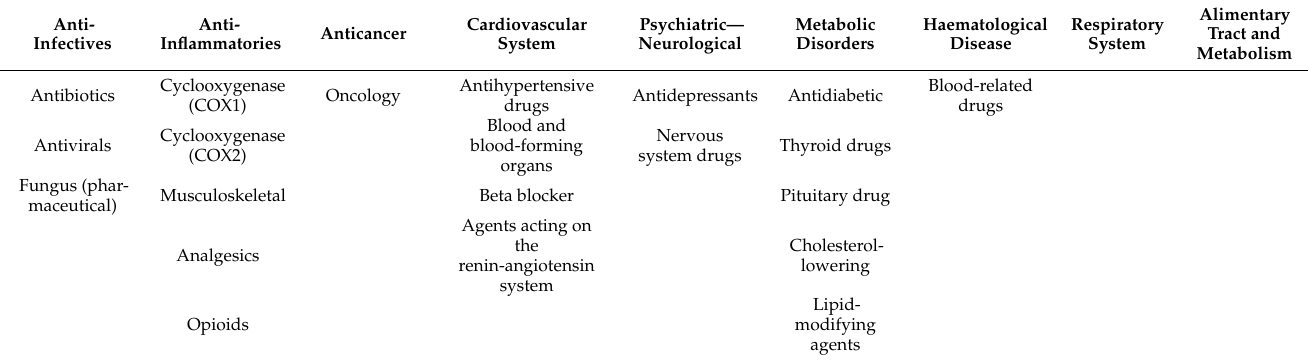
Table 2. Keywords used in the pharmaceutical groups under